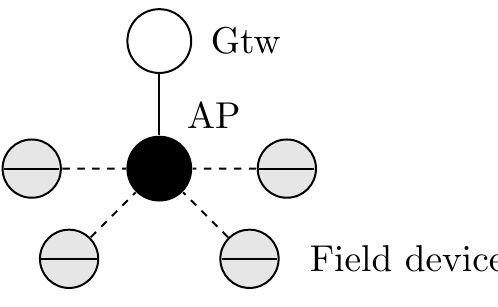
Figure 14. A star topology composed of four field devices.